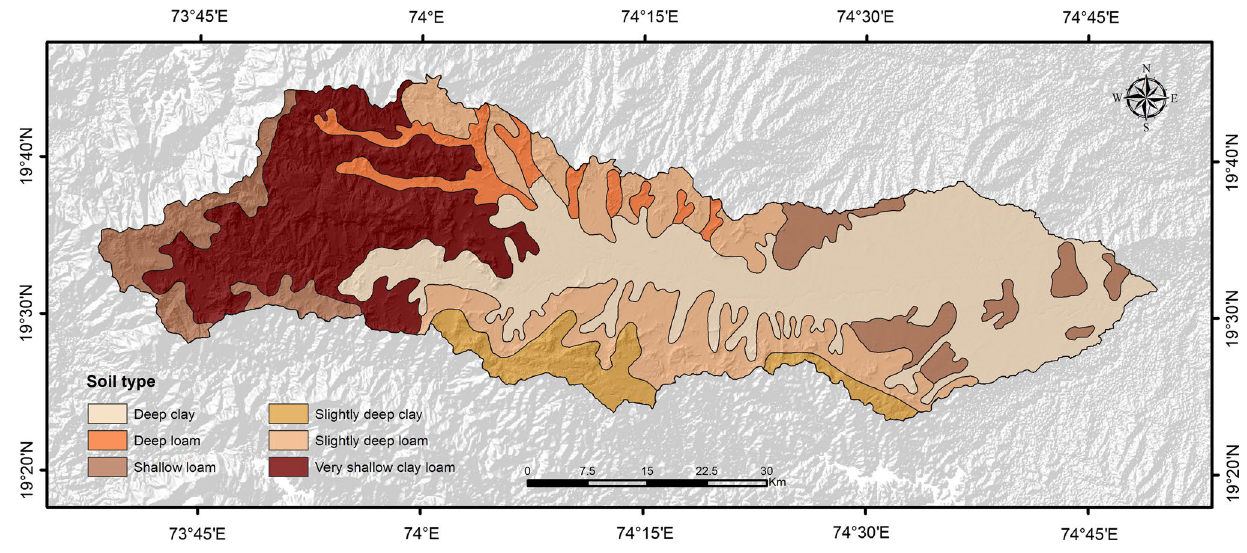
Fig. 12 Distribution of different soil textures in the study